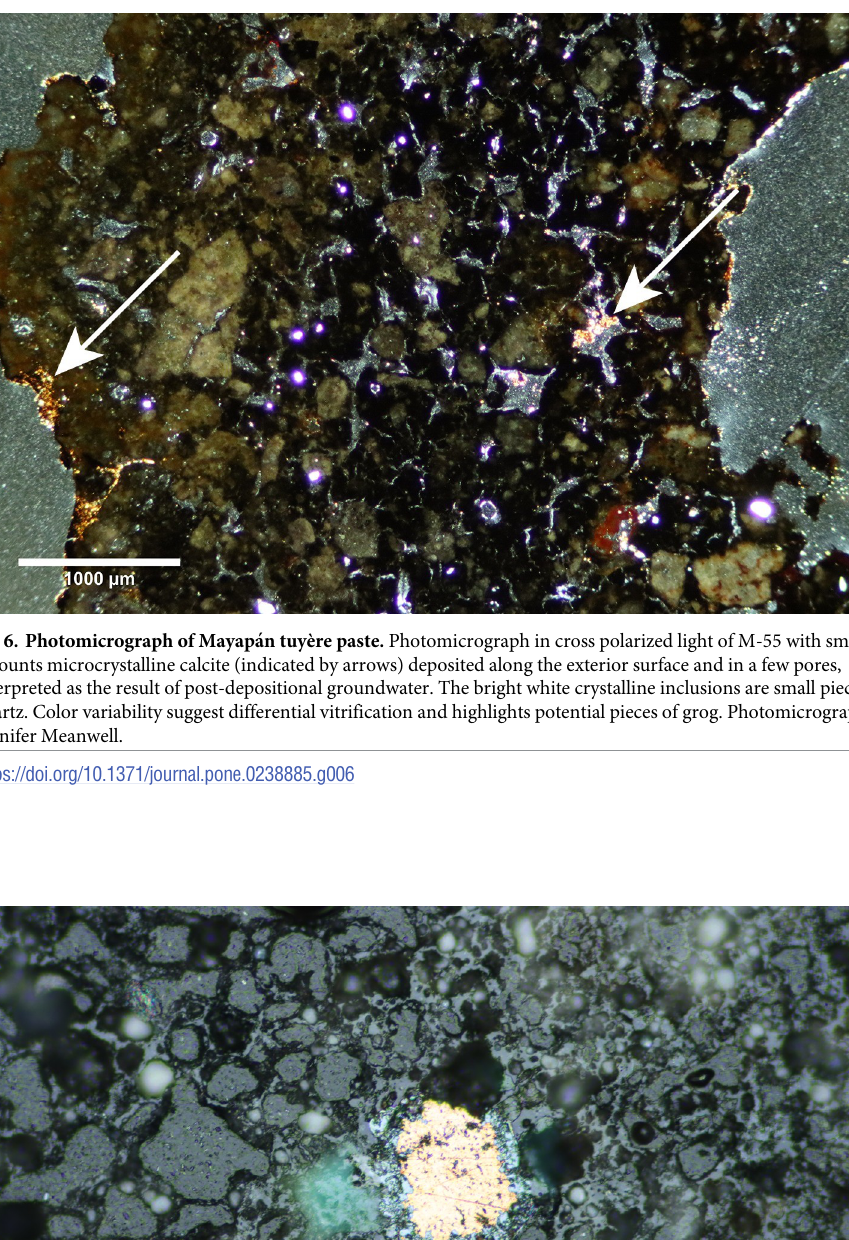
PLOS ONE | https://doi.org/10.1371/journal.pone.0238885 September 22,